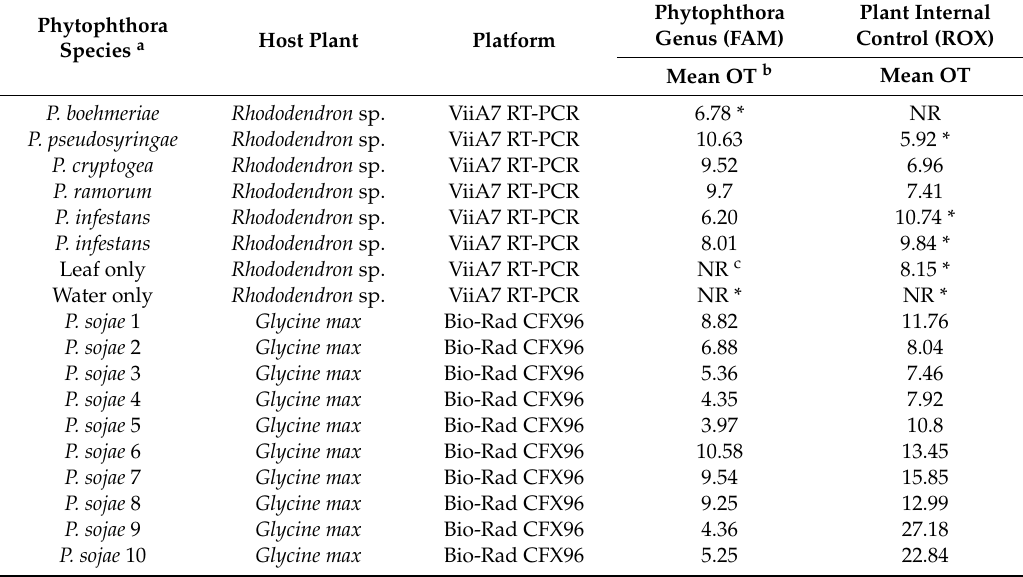
Table 4. Horticulture ( Rhododendron sp.) and agriculture (soybean) samples tested with the preformulated lyophilized recombinase polymerase amplification (RPA) assay. Phytophthora Host Plant Platform Species a